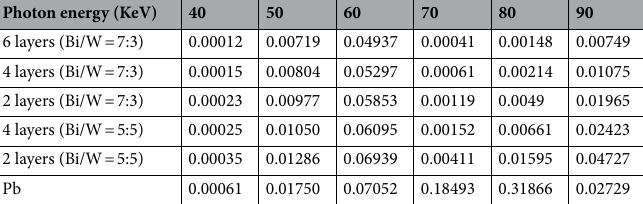
Photon energy (KeV)